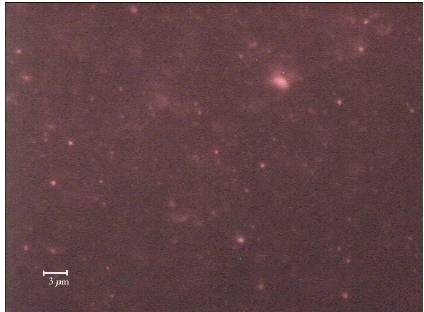
Figure 1. Optical microscopy images of SQ-Dox-loaded SLNs, Formulation 1.